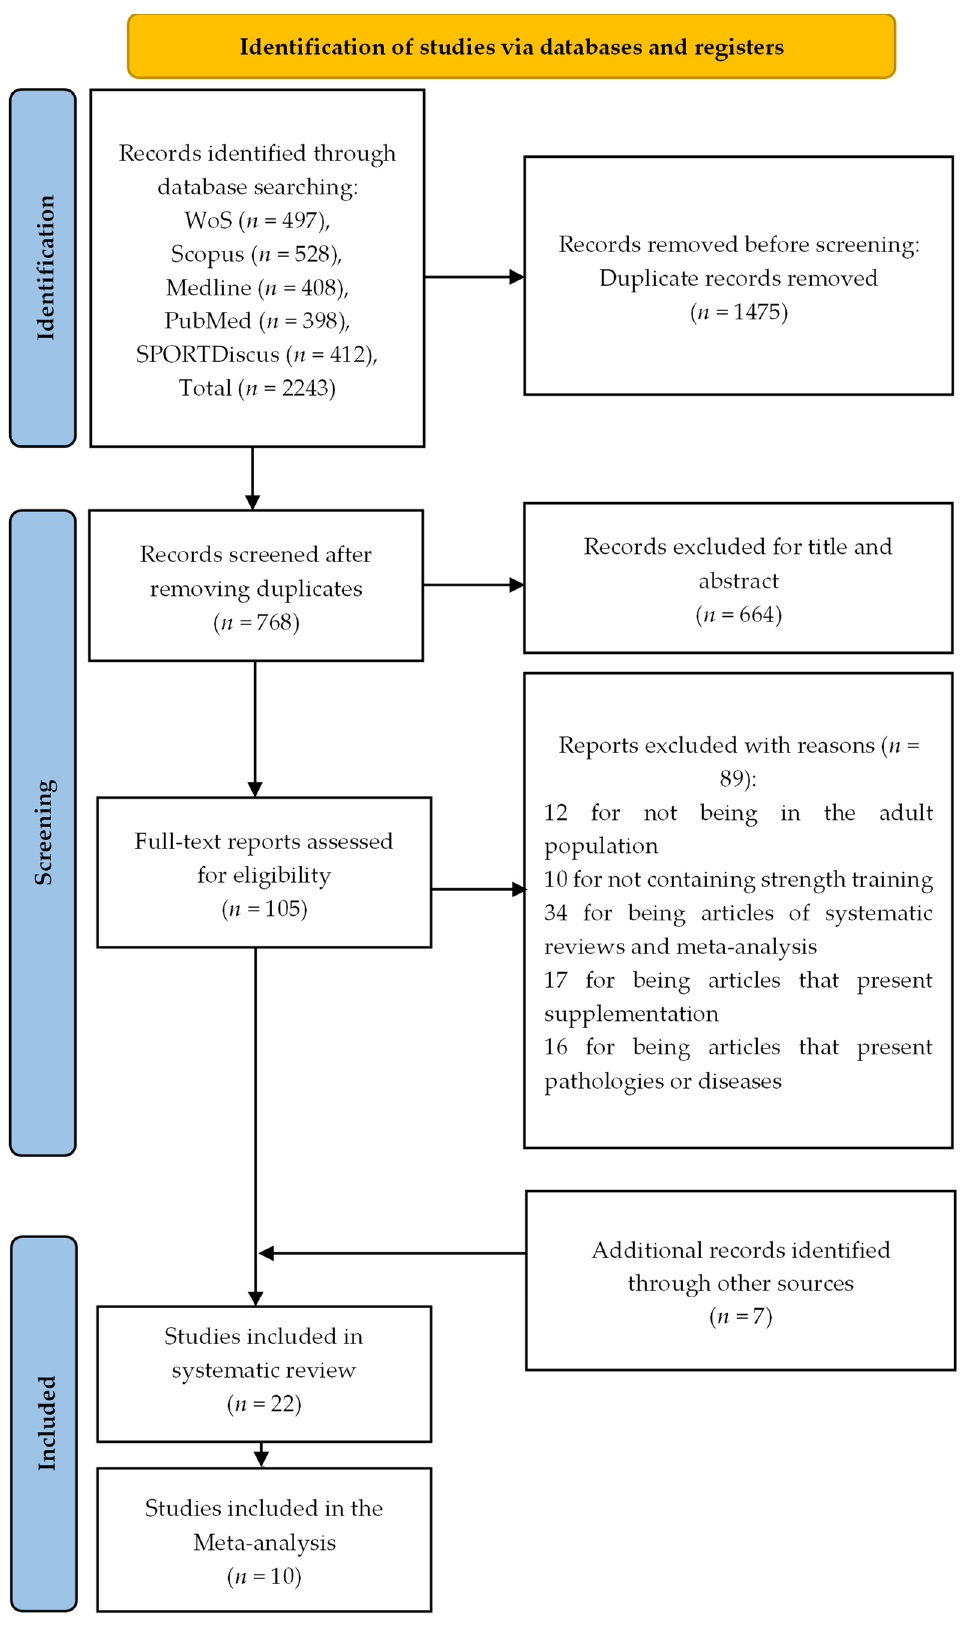
Figure 1. This is a figure. Schemes follow the same formatting. Figure 1. Flowchart summarizing the process of study